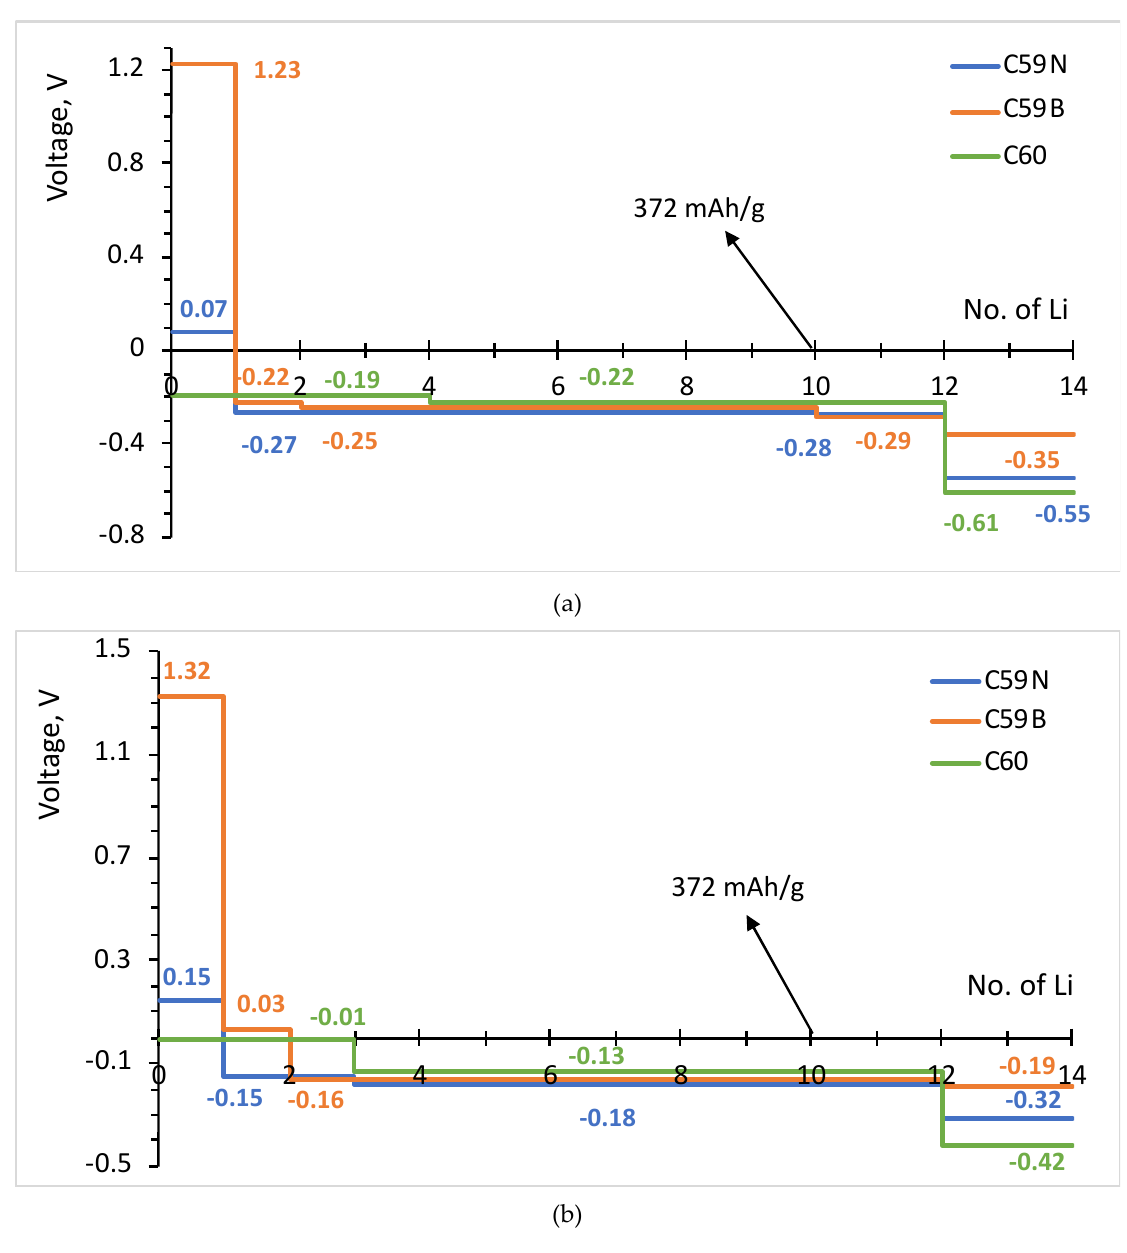
Figure 4. Voltage–capacity curves estimated for lithium attachment to molecular C 60 , C 59 N and C 59 B computed with B3LYP ( a ) and PBE ( b ) functionals.